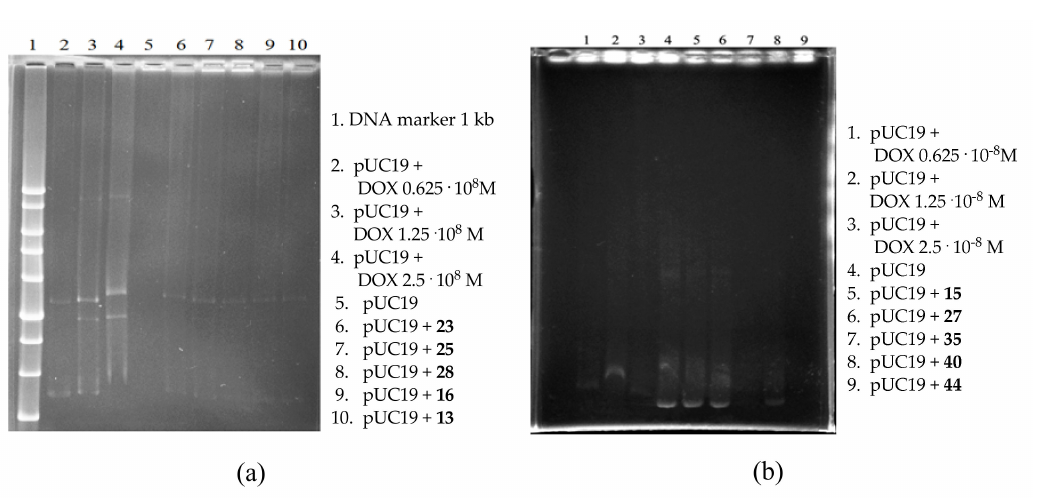
Figure 3. Gel retardation assay of tested aryl(furyl) substituted 1-hydroxyanthraquinones 13 , 16 , 23 , 25 , 28 ( a ) and (4-methoxyphenyl) substituted compounds 15 , 27 , 35 , 40 , 44 ( b ) with pUC19 DNA